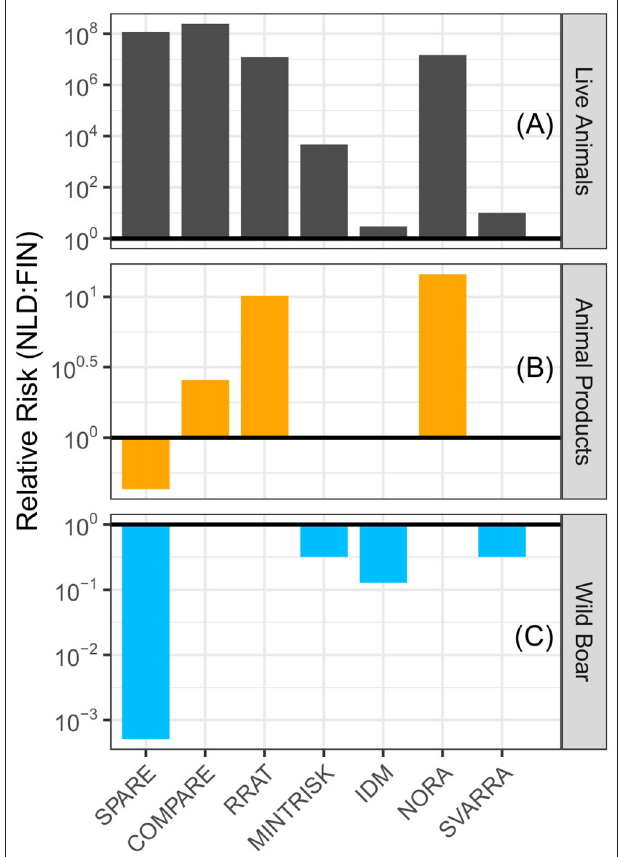
FIGURE 3 | Relative risk of introducing ASF into the Netherlands compared to Finland in the baseline scenario (2017 situation) by (A) trade in live animals, (B) trade in animal products, and (C) movement of wild boar. A relative risk above 1 (bold line) denotes the Netherlands has a higher risk than Finland, while a relative risk below 1 denotes Finland has a higher risk. Please note the different scales used on the